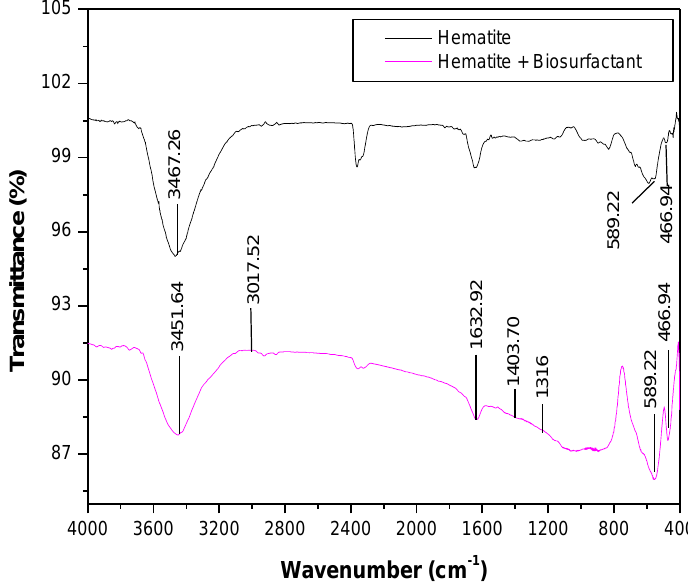
Figure 3. Fourier transform infrared (FTIR) spectra of hematite before and after interaction with biosurfactant.